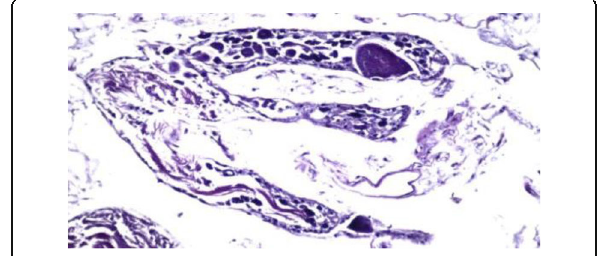
Fig. 3 Ovotestis of Eobania vermiculata gp untreated snail (I-1)